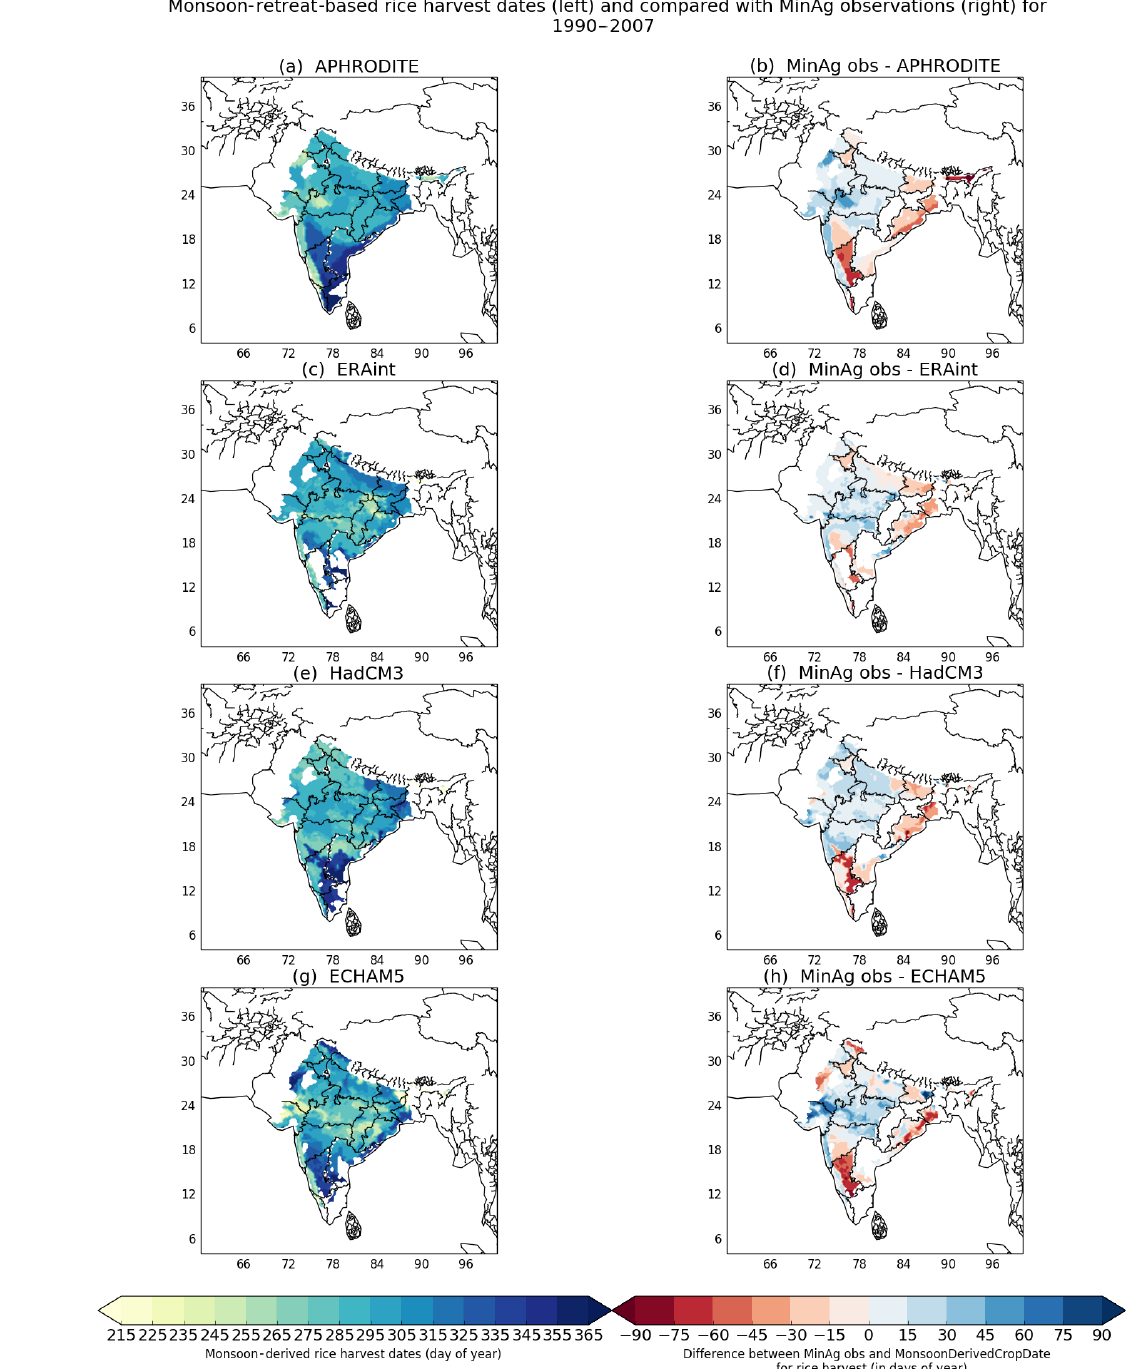
Figure C1. The monsoon-derived rice harvest dates (a, c, e, g) and the difference between the MinAg observations and the monsoon-derived rice harvest dates (b, d, f, h) for the period 1990–2007.